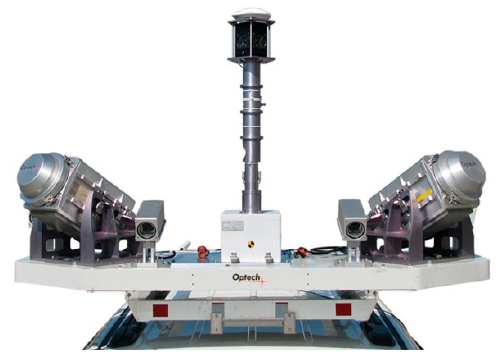
Figure 1. LYNX Mobile Mapper manufactured by Optech. Table 1. Technical specifications of Optech LYNX Mobile Mapper.